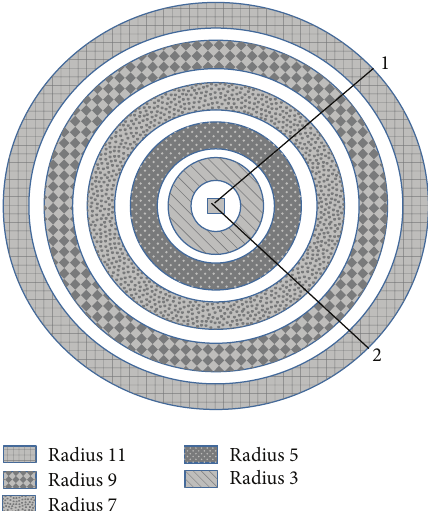
Figure 1: Corner point, corresponding edges, and 5 radii around it used to identify internal and external part for description.